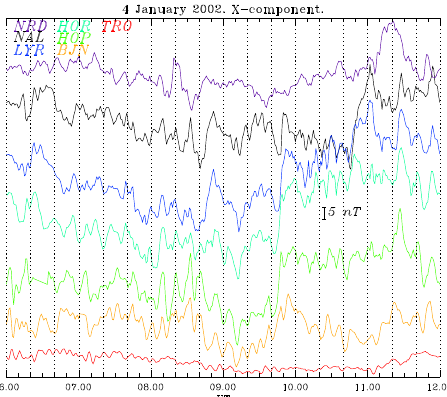
Figure 3. Magnetograms of X component magnetic variations along the IMAGE + Greenland 100 ◦ magnetic longitude profile from 06:00 to 12:00UT on 4 January 2002.